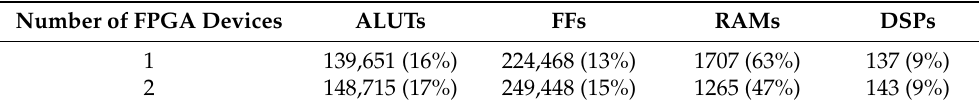
Table 4. Comparison of resource utilization.